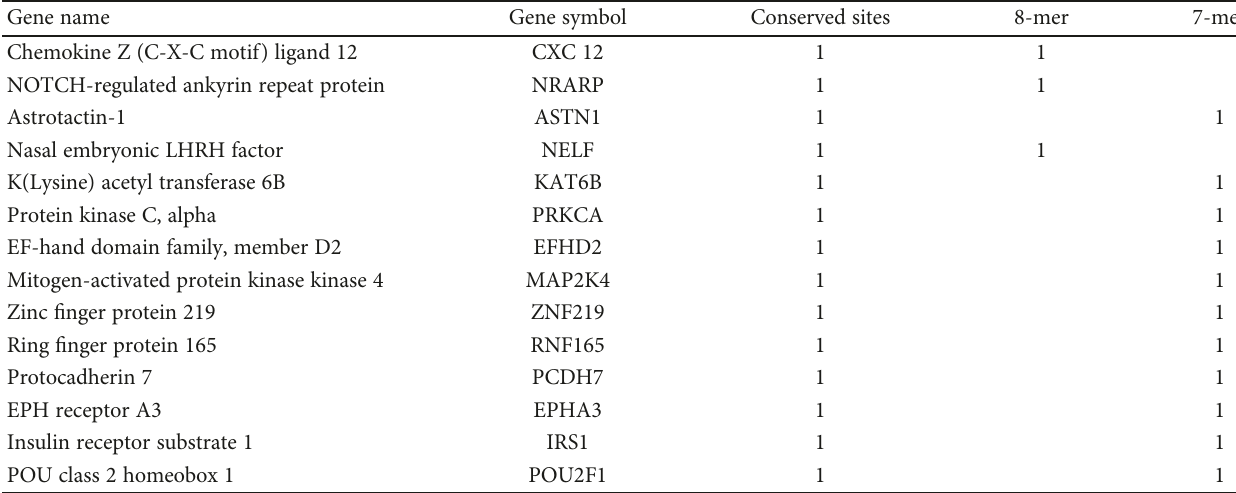
Table 3: Transcripts with conserved 3 ′ UTR sites for